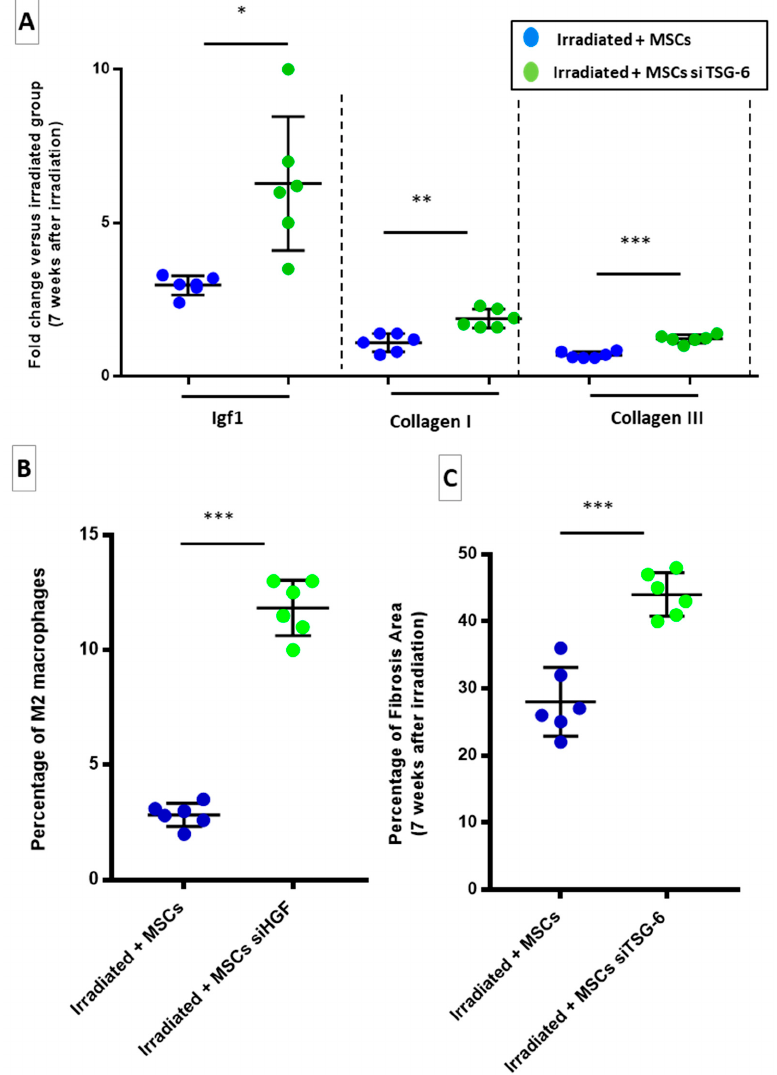
Figure 7. TSG-6 silencing in transplanted MSCs induces pro-fibrotic signals in irradiated rats and stimulates ECM production (7 weeks after irradiation). ( A ) mRNA fold changes in fibrosis-related genes 7 weeks after irradiation that are normalized to Ywhaz and standardized against irradiated group. MSCs silenced for TSG-6 induce a strong remodeling in colon–rectum area of irradiated rats, mainly by collagen produced by SMCs activated by IGF-1. ( B ) Percentage of M2 macrophages 7 weeks after irradiation (4 weeks after MSC injection) as identified by CD68-CD206 co-staining. MSCs silenced for TSG-6 stimulate chronic activation of pro-fibrotic M2 macrophages. ( C ) Percentage of fibrosis area quantified on Picrosirius Red-stained paraffin-embedded slides show a significant increase in ECM deposition after transplantation of MSCs silenced for TSG-6. Each group of animals was composed of 6 rats. The results of each group were compared as follows: Irradiated + MSCs siHGF and Irradiated + MSCs siTSG-6 groups were compared to Irradiated + MSCs group. Two-group comparisons were performed with t -tests, while one-way ANOVAs, followed by Bonferroni t -tests, were used for multiple group comparisons. The results are expressed as mean ± SD. *: p < 0.05; **: p < 0.01; ***: p ≤